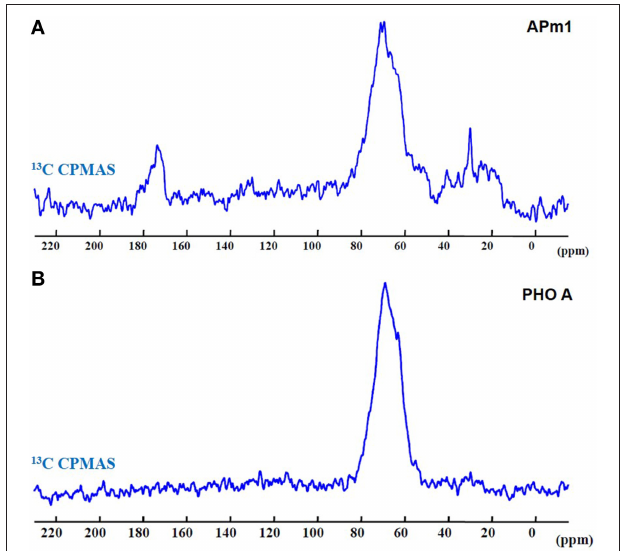
FIGURE 9 | 13 C CPMAS spectra of the Ca-phosphate precipitates formed in the presence of APm1 (A) and PHO A (B), after 2 weeks in the calcification